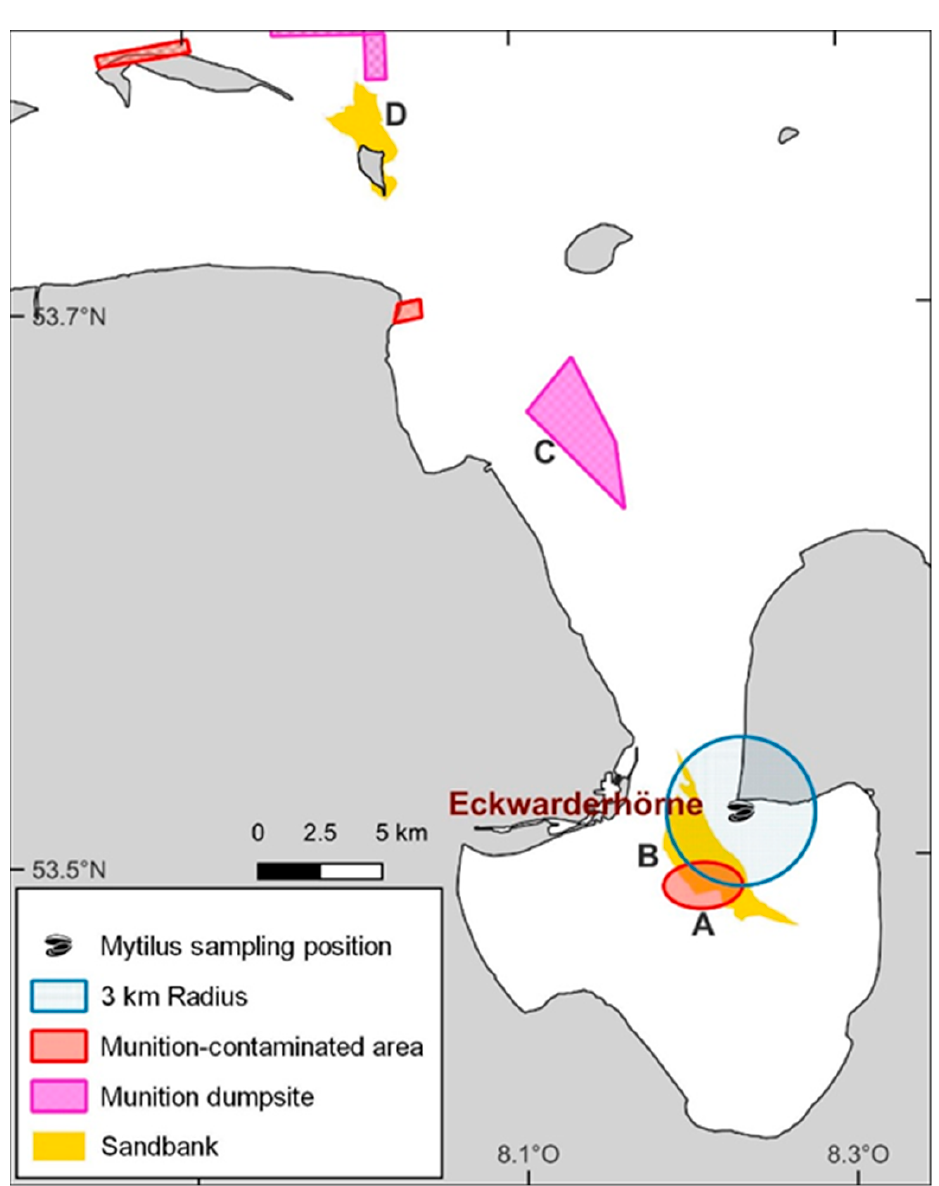
Figure 3. Map of the Mytilus sampling area of the Environmental Specimen Bank “Eckwarderhörne” in the German North Sea. ( A ) The munition-contaminated area Jappensand, ( B ) Jappensad shoal, ( C ) the munition dumpsite Hooksielplate, ( D ) the island Minsener Oog with shoal.